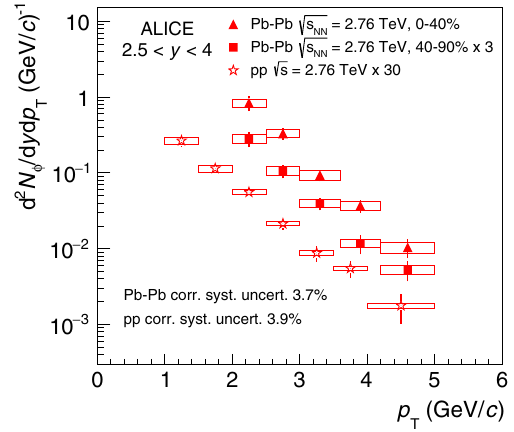
Fig. 5 φ yield as a function of p T at forward rapidity in pp [57] and Pb–Pb collisions for different centralities. The distributions have been scaled differently for better